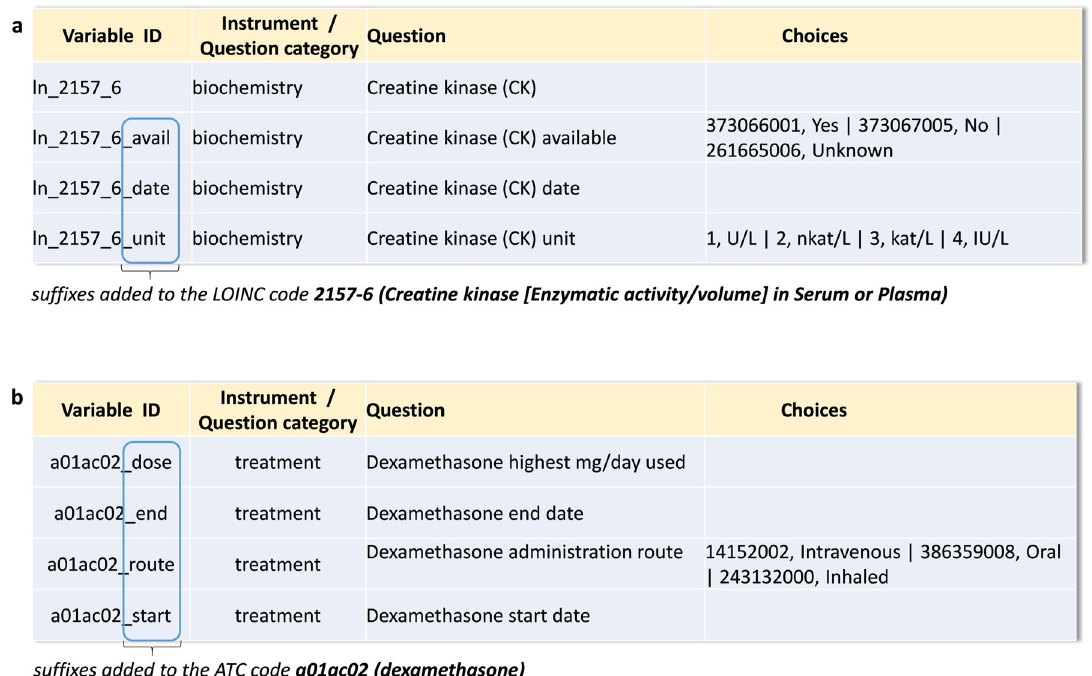
Fig. 8 Incorporation of suf fi xes into the standardized variable names of data used in the Long-Term Sequelae and Fragile Population studies. a Overview of suf fi xes used as part of the variable names for the laboratory component creatine kinase which was coded with the appropriate LOINC code. b Overview of suf fi xes added to the ATC code for dexamethasone as part of the variable names of the related data elements. U/L: Unit per liter, nkat/L: Nanokatal per liter, kat/L: Katal per liter, IU/L: International unit per